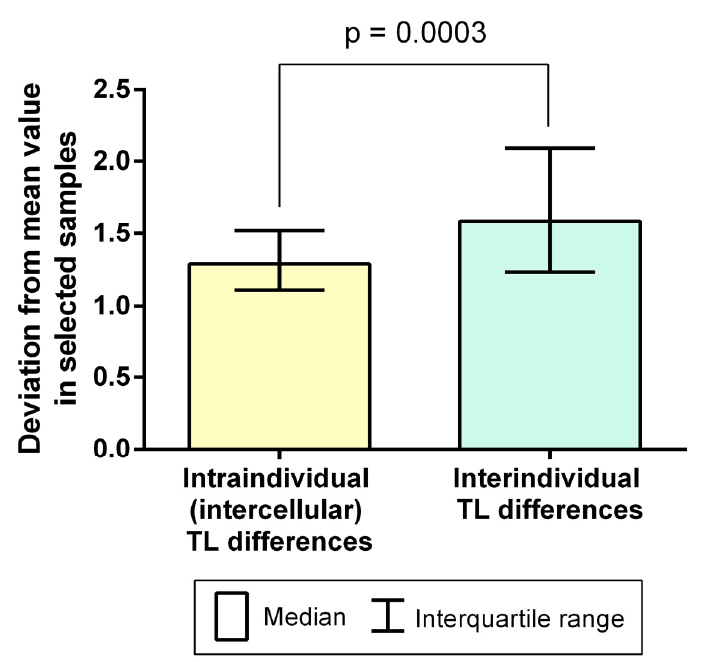
Figure 6. A significant excess of interindividual variability over intraindividual (intercellular) variability calculated based on telomere length (TL) assessment in triploid zygotes (the Mann–Whitney U test, p = 0.0003).